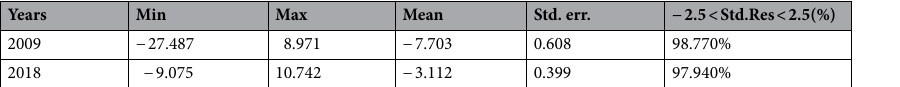
Table 4. Descriptive statistics of regression coefficients in the GWR